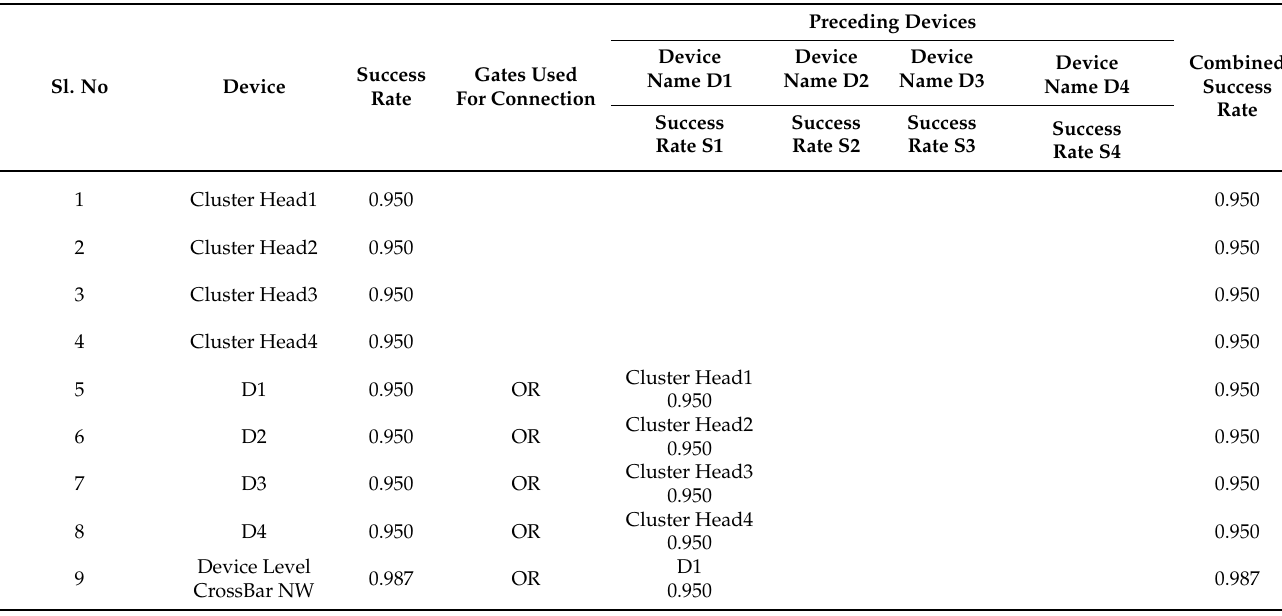
Table 4. Success rate computations of the revised IoT